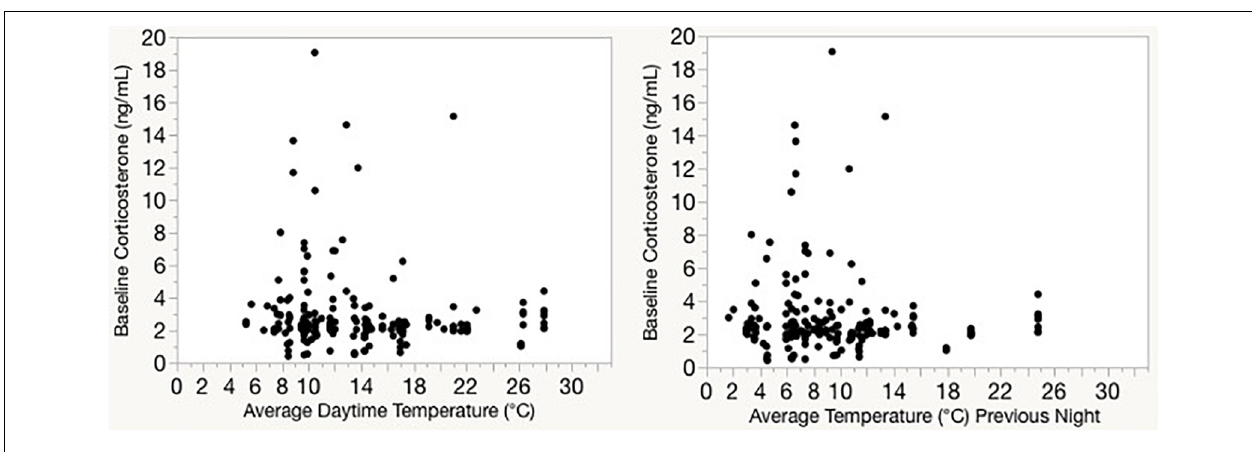
FIGURE 6 | Baseline corticosterone samples from wintering Gambel’s white-crowned sparrows collected at multiple sites in Davis, CA between 2007 and 2014. Corticosterone levels are not significantly correlated with average temperature for the day on which the sample was taken (left) , or with the average temperature from the night prior to sampling (right) . Temperatures are obtained from a local weather